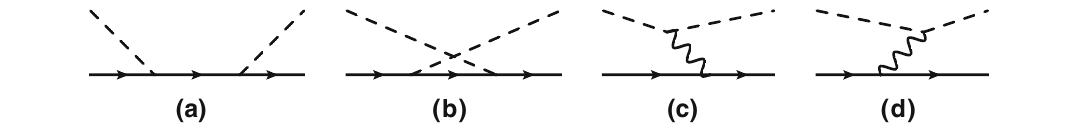
Fig. 1 Time-ordered diagrams contributing to the LO meson–baryon potential. The solid, wiggled and dashed lines correspond to baryons, vector mesons and pseudoscalar mesons,